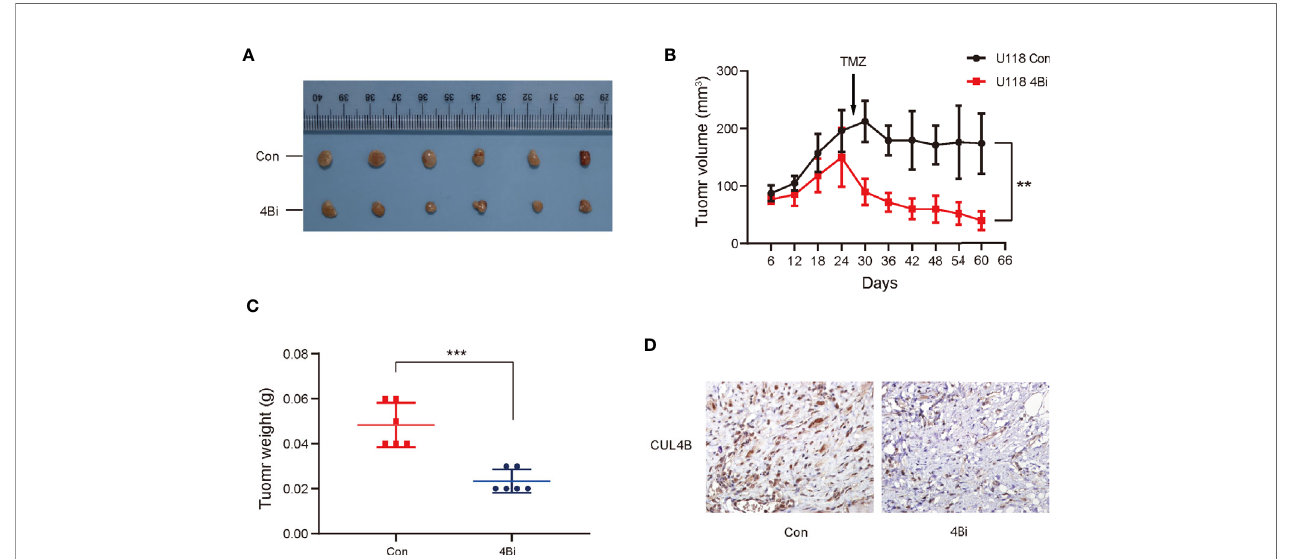
FIGURE 3 | Down-regulation of CUL4B in GBM cells enhance sensitivity of TMZ in vivo . Indicated U118 cells were injected into the fl anks of nude mice. (A) Images of the xenograft tumors derived from U118 Con and U118 4Bi cells. (B) Growth curves of tumors from nude mice implanted with indicated cells. (C) Tumor weight of the xenografts after dissection. (D) Representative images of IHC staining of expression of CUL4B in tumors from nude mice. (***P < 0.001, **P <